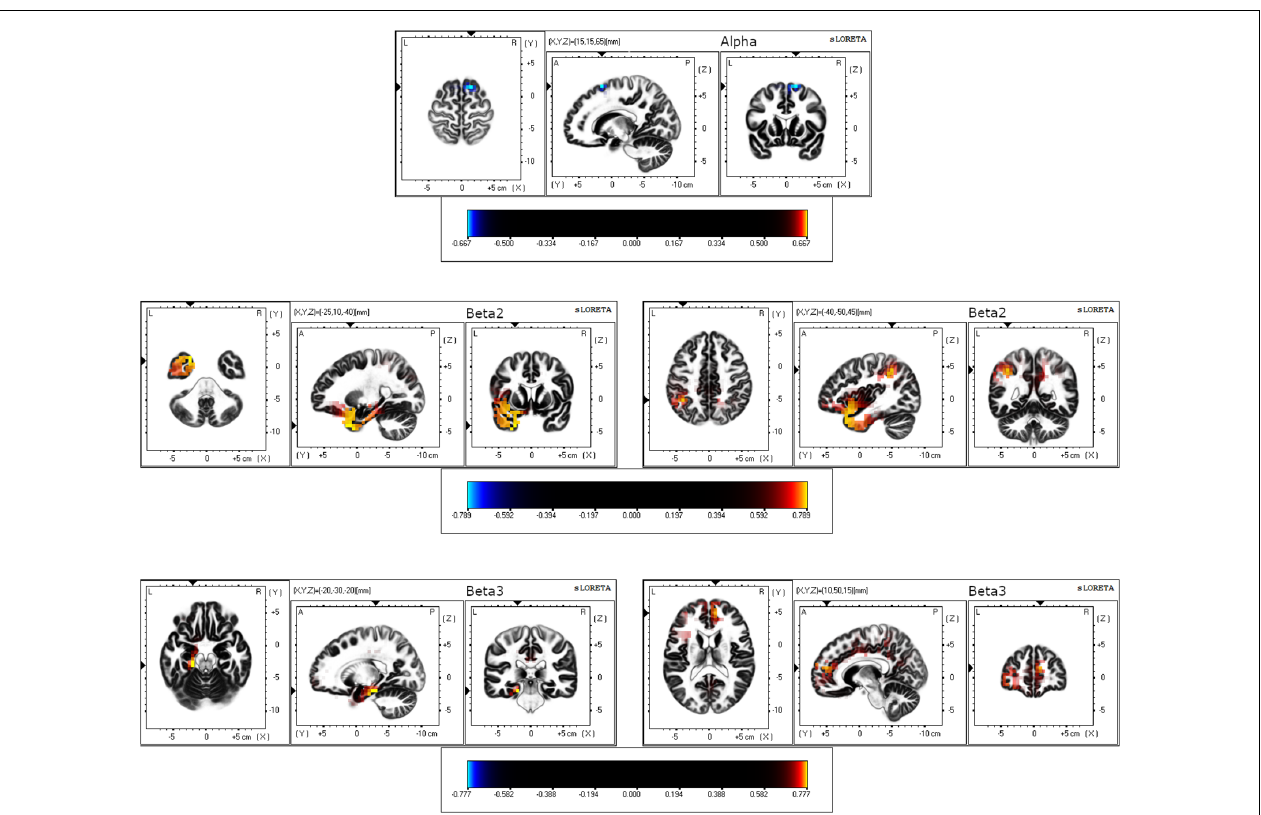
FIGURE 1 | eLORETA results for three orthogonal brain slices (horizontal, sagittal, coronal) of alpha, beta2, and beta3 frequency bands. For alpha, the coordinate with the highest significance level is shown. For beta2 and beta3, the coordinates with the highest (left) and the second-highest (right) significant levels are displayed. Blue-colored voxels represent decreased ( p < 0.05) current density in the older group compared to the younger group. Red/yellow-colored voxels represent increased ( p < 0.05) current density in the older group compared to the younger group.